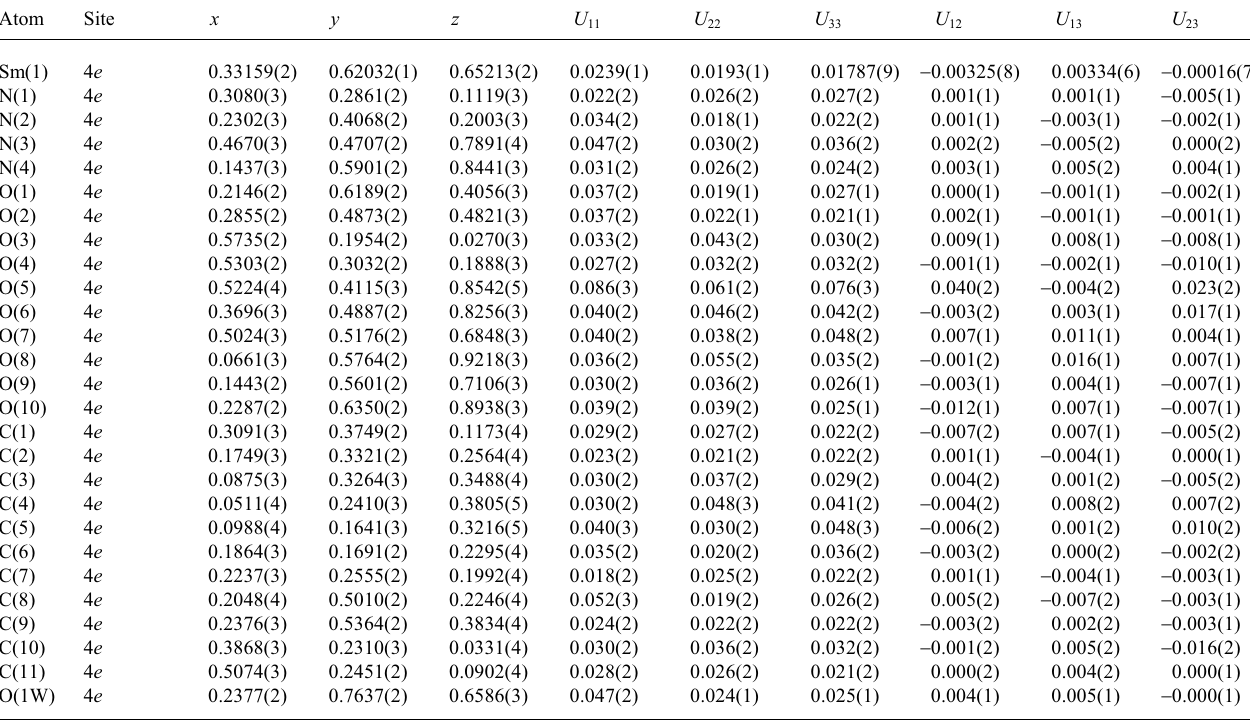
Table 3. Atomic coordinates and displacement parameters (in Å 2 )